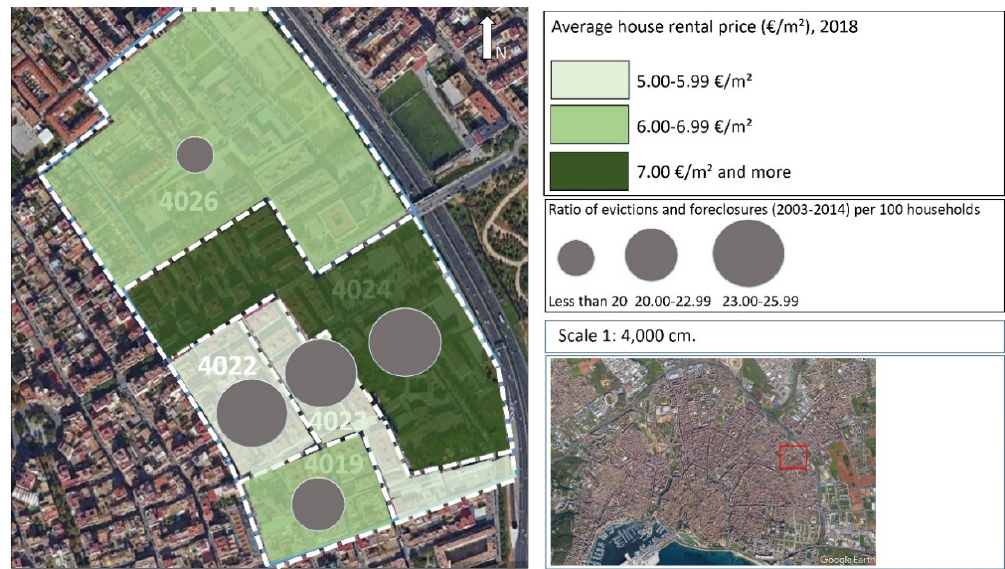
Figure 10. Average price of rental homes and evictions and foreclosures by census sections. Source: Prepared by the author based on the State System of Housing Rental Indexes and SCNE data.